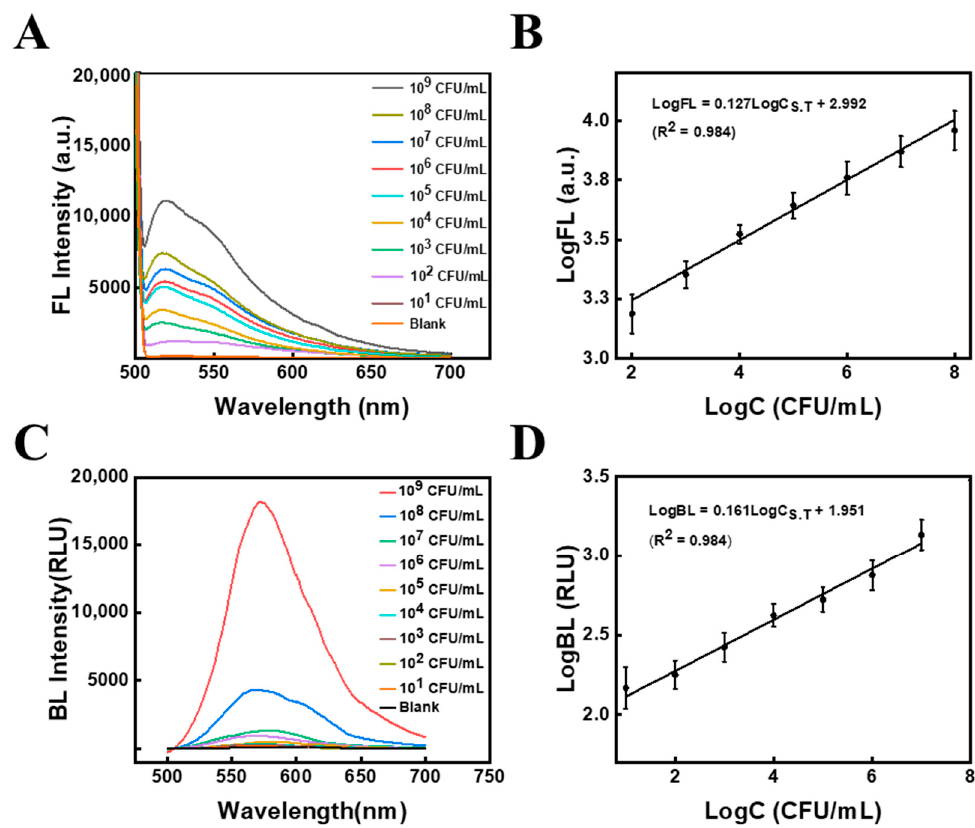
Figure 5. ( A ) Fluorescence intensity signals at different S.T concentrations and ( B ) their correspond- ing standard curves. ( C ) Bioluminescence intensity signals at different S.T concentrations and ( D ) their corresponding standard curves.